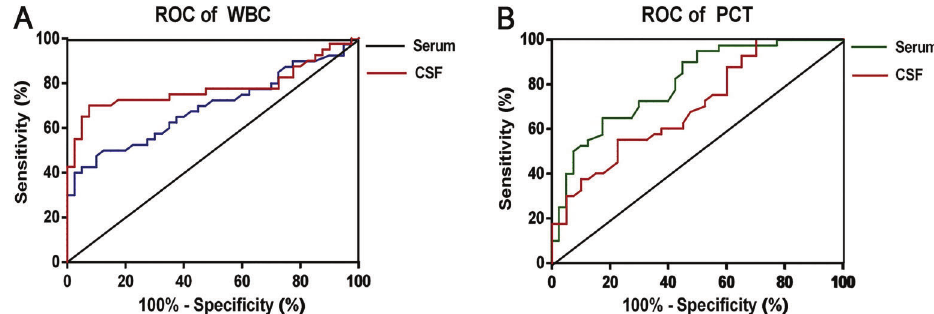
Figure 1. Receiver operating characteristics (ROC) curve of serum and cerebrospinal fl uid (CSF) white blood cell (WBC) ( A ), and serum and CSF procalcitonin (PCT) ( B ) in diagnosis of intracranial infection after craniotomy (n=39).